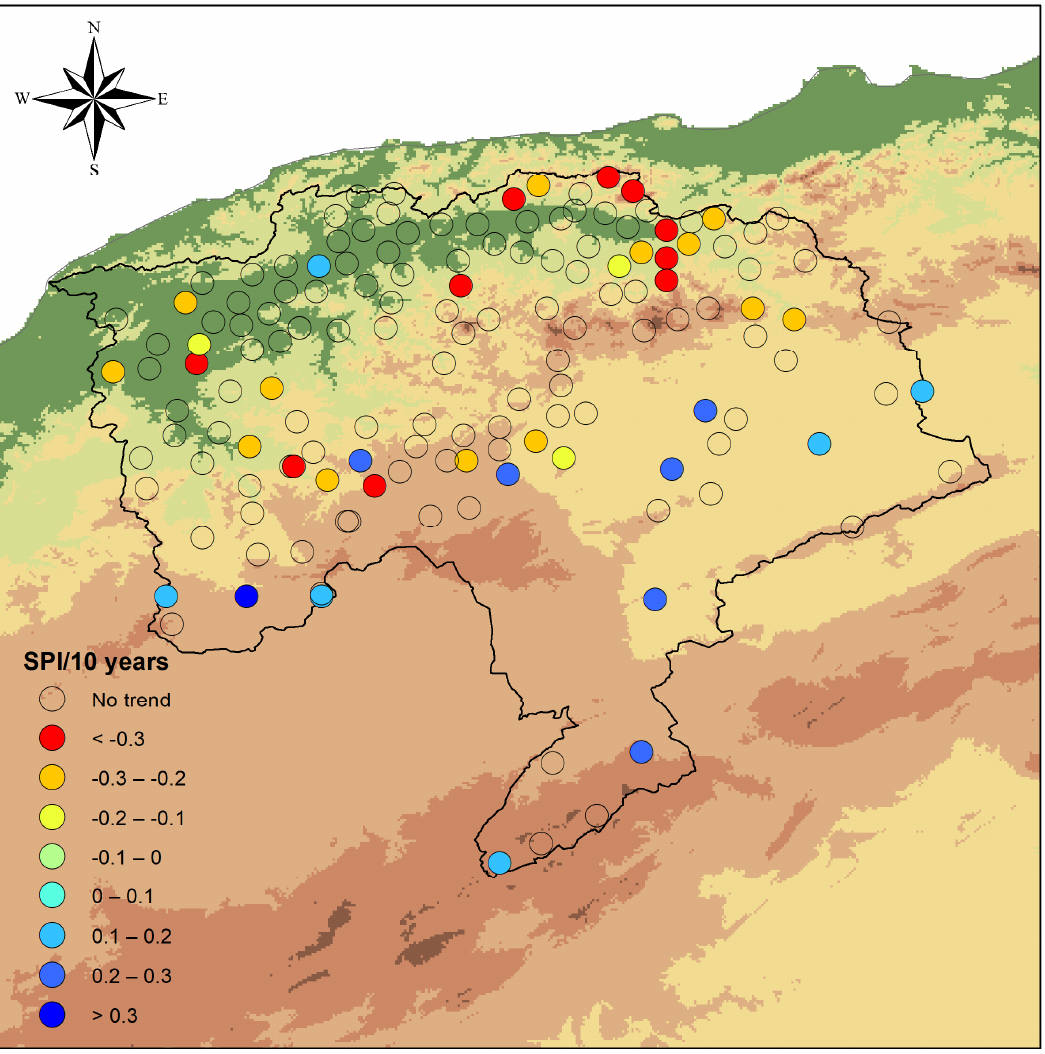
Figure 6. Spatial results of the trend analysis performed on the SPI values. The trend magnitude has been evaluated with the Theil–Sen estimator; the statistical significance of the trends, with a SL = 95%, has been assessed with the Mann–Kendall test. Colored points indicate significant trends.